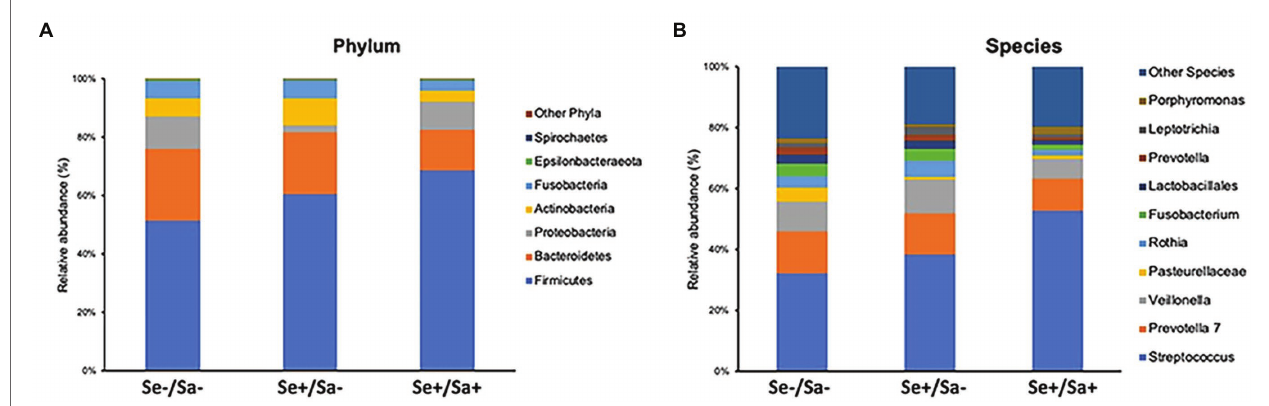
FIGURE 3 | The top phylum and species in three groups of HIV patients with or without KSHV coinfection.